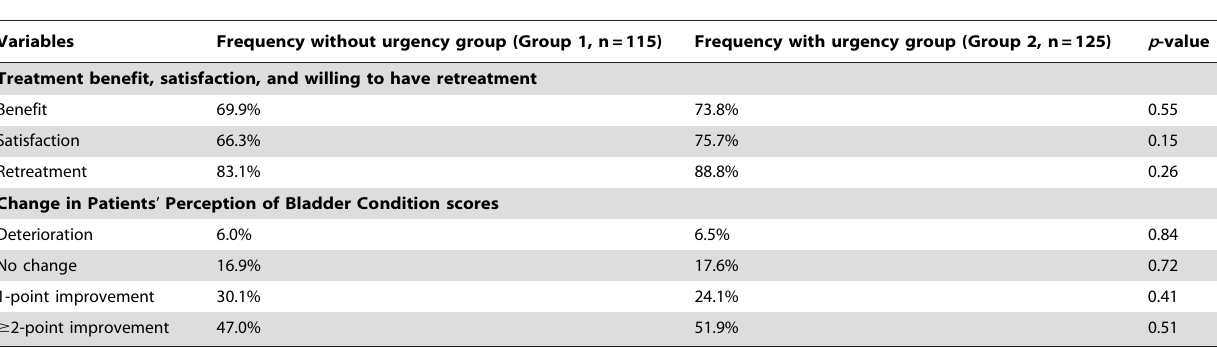
Table 3. Patients’ perception of treatment benefit, satisfaction, and willing to have retreatment and Changes in Patients’ Perception of Bladder Condition scores.